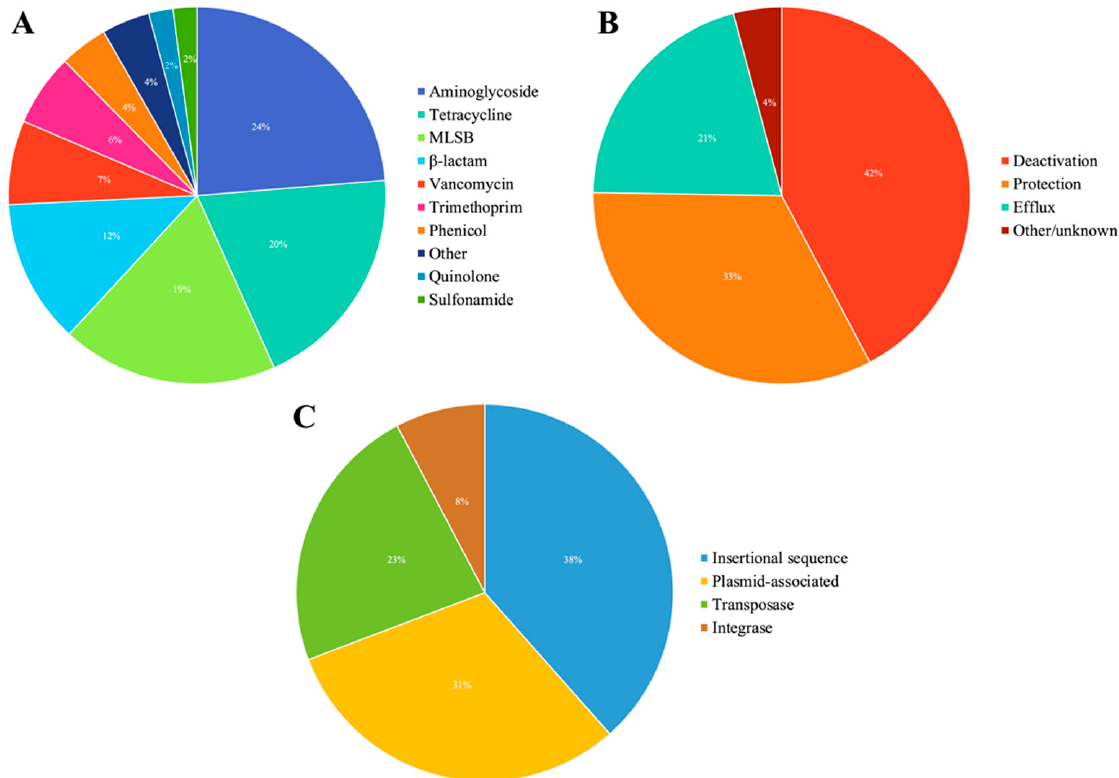
Figure 1. Diversity of ARGs identified in red fox faecal samples classified according to the antibiotic class to which they confer resistance ( A ), their resistance mechanism ( B ) and the types of MGEs ( C ). According to the location, red foxes from FreitaAMM had a high diversity of ARGs and MGEs with 115 positive assays, whereas foxes from MontesinhoNP tested positive in 62 assays (Figure 2A). DNA from FreitaAMM samples amplified a high number of unique genes ( n = 61) when compared to MontesinhoNP ( n = 8), and 54 genes were found in the samples of both study areas. The 90 ARGs identified in foxes living in FreitaAMM belong mainly to aminoglycosides (26%), MLSBs (20%) and tetracyclines (18%) (Table S2). In samples from MontesinhoNP, the 45 ARGs are mainly associated with the resistance to aminoglycosides (24%), tetracyclines (22%), and MLSBs (18%) (Table S2). None of the tested ARGs of the trimethoprim group were detected in samples from MontesinhoNP (Figure